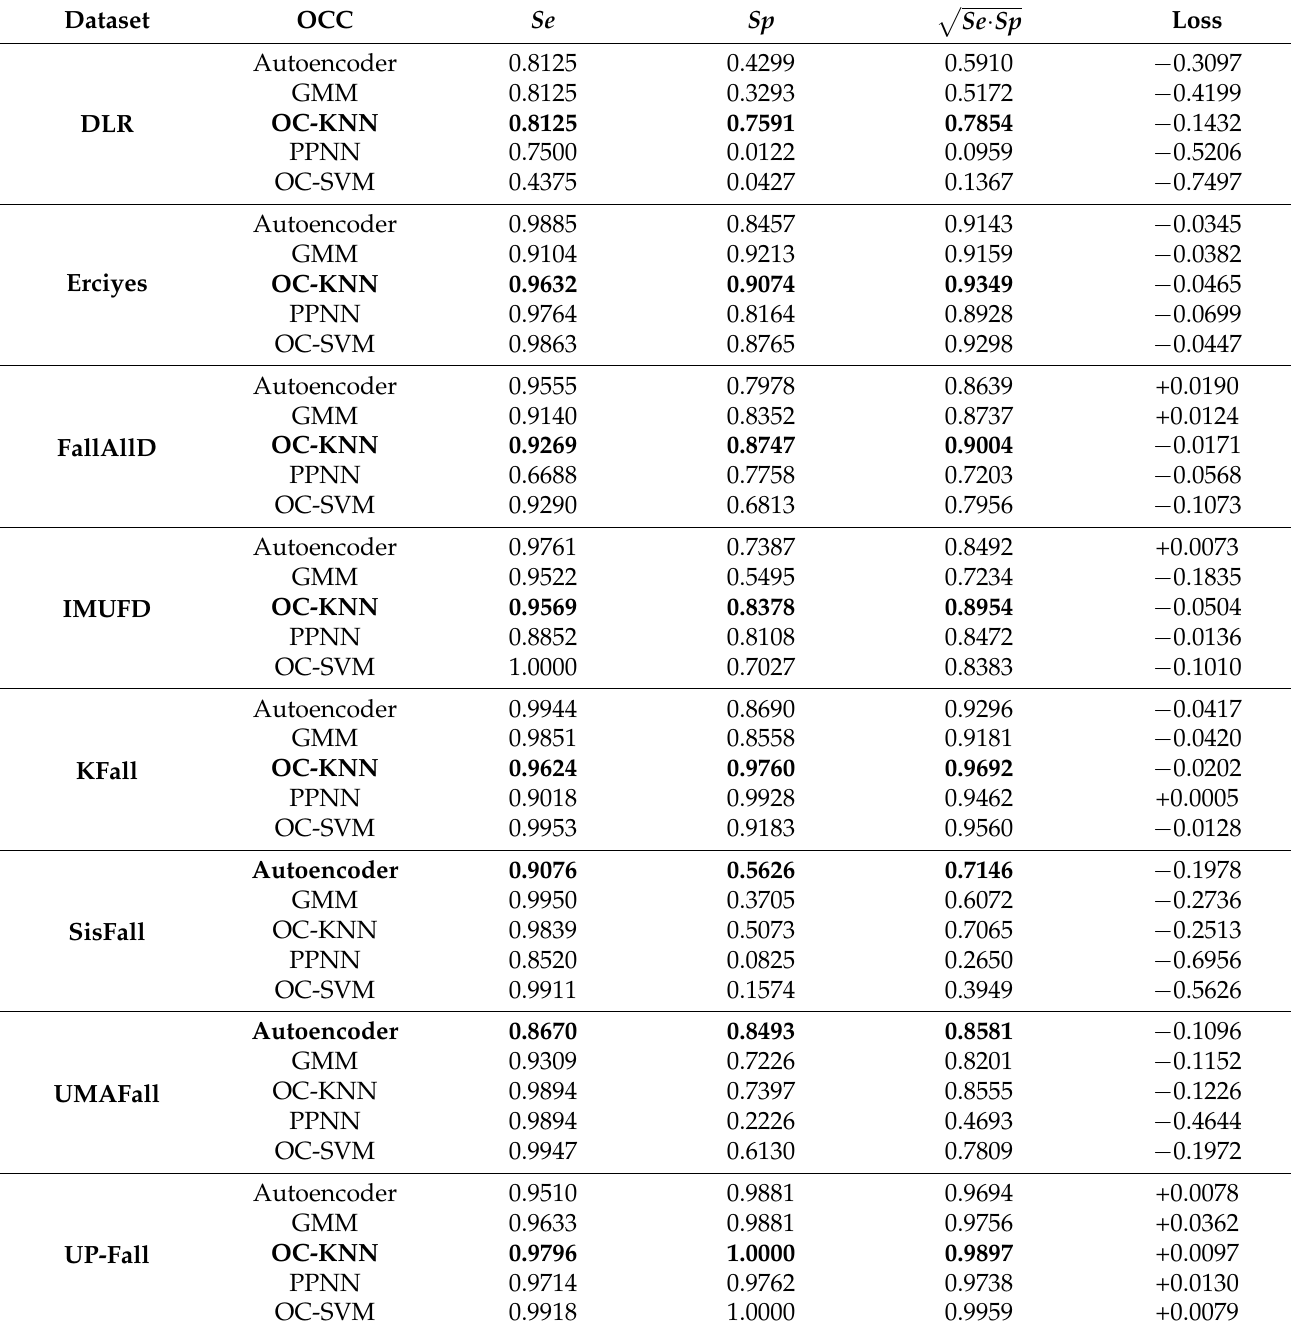
Table 11. Results of the classifiers when they are tested with falls and basic activities and trained with the rest of ADL categories.